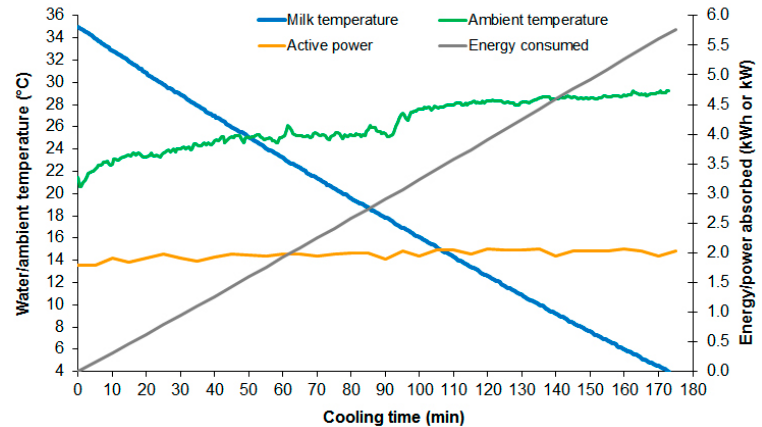
Figure 2. An example of performance and energy consumption test conducted with water on an 800 L milk cooling tank 2BII and V r of 0.50 (milk cooling system (MCS) No. 16), showing the cooling curve, the active power and the electricity consumption.